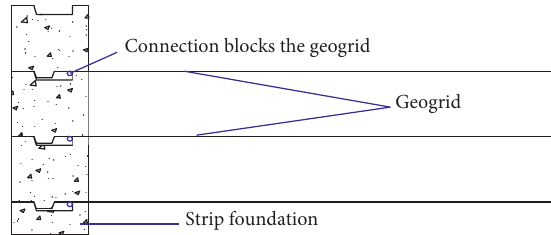
Figure 5: Connection between geogrid and